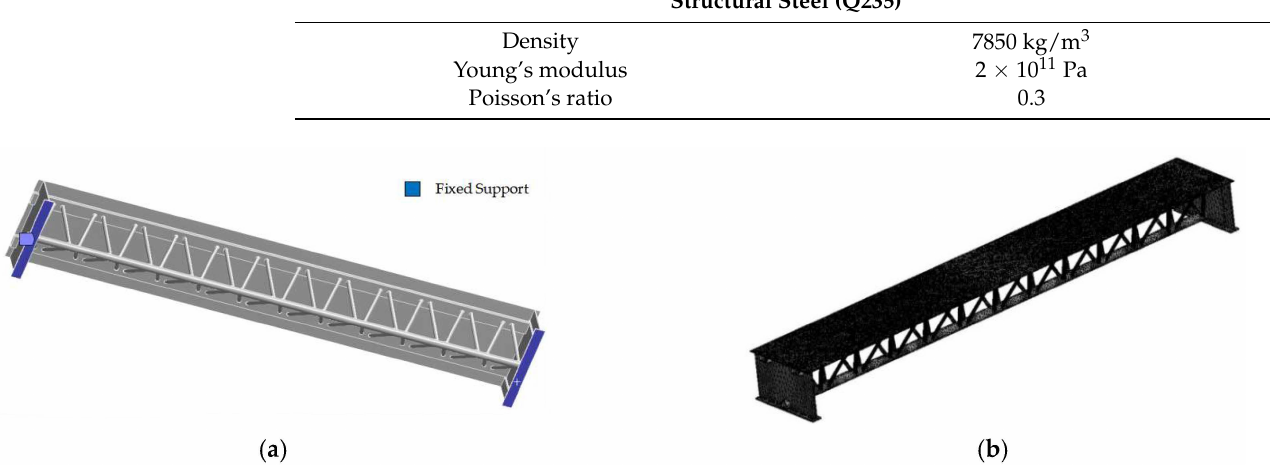
Figure 5. Finite element settings for STTGB. ( a ) Constraint position; ( b ) finite element